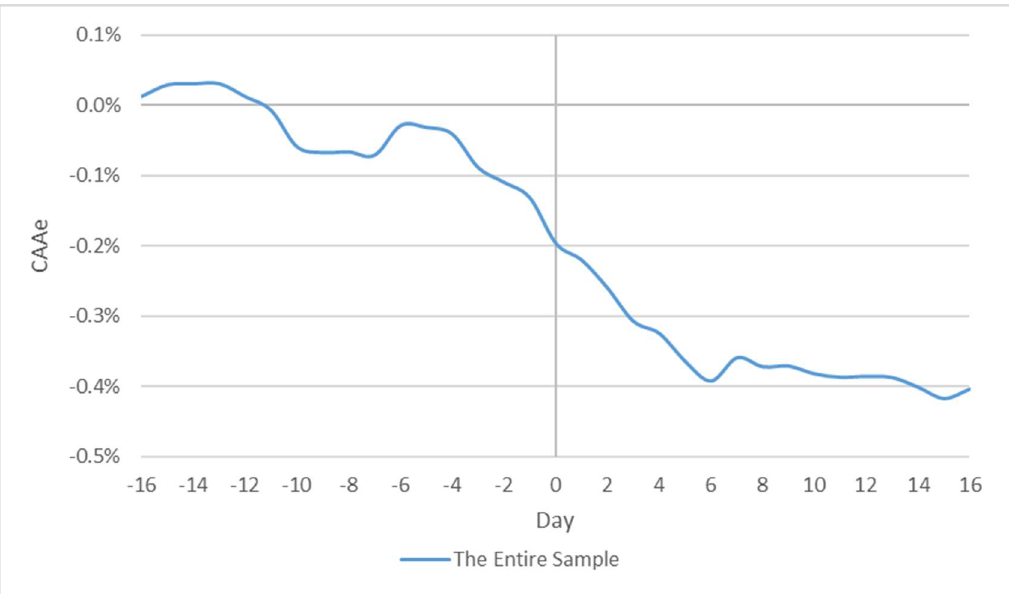
Figure 3. The cumulative average abnormal exchange rate return (CAAe) behavior during the 33-day event window surrounding the event day for the entire sample of 296 announcements.